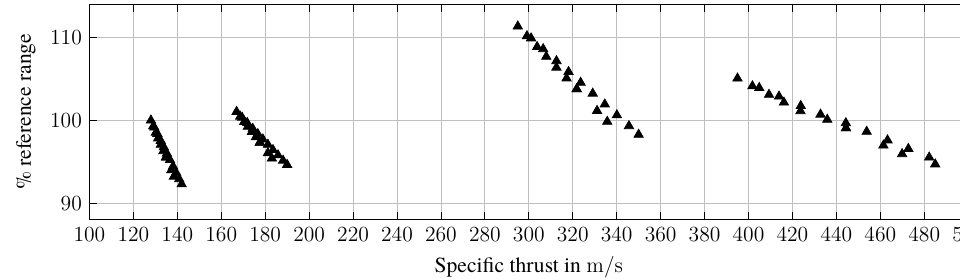
Figure 10. Achievable aircraft range for the underlying engine